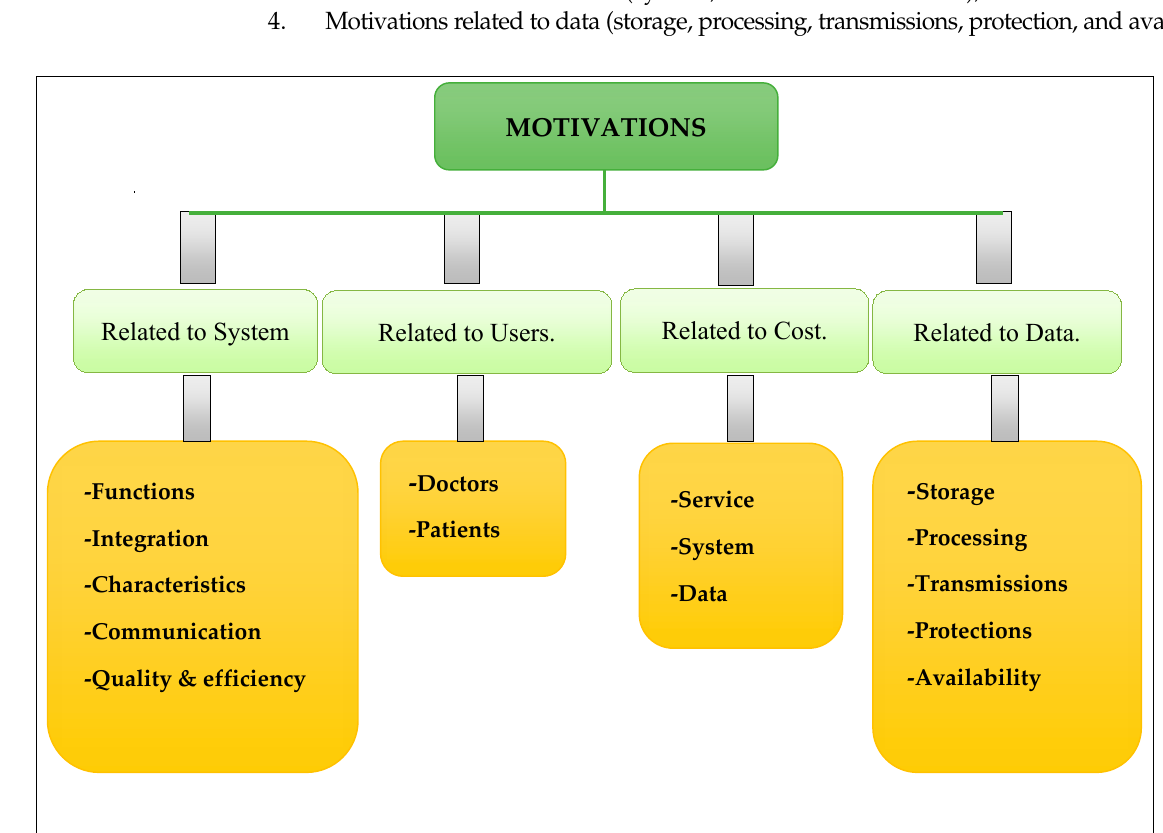
Figure 9. Categorized Motivations sections.